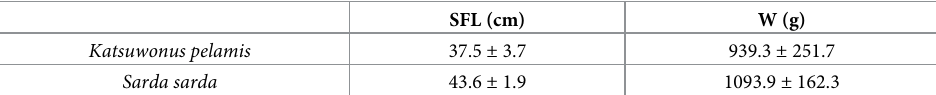
Table 1. Fish biometric